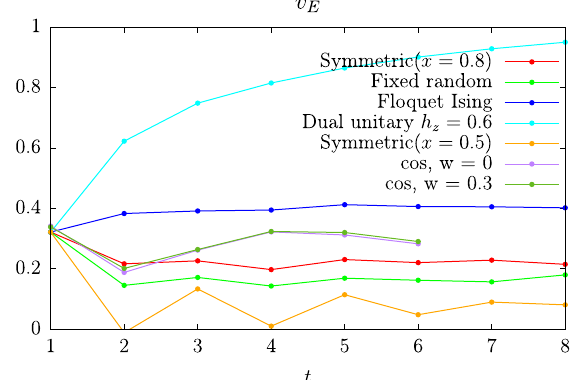
FIG. 19. The approximate entanglement velocity v computed E by truncating to times ≤ t , for t up to 8. The first four curves are for the four circuits studied in Sec. V [the first three are also the subject of Fig. 18(b) for v ]. The fifth shows the generic B symmetric gate [Eq. (72)] at a weaker coupling strength. The two curves with w ¼ 0 and w ¼ 0 . 3 are the entanglement velocities for the Floquet Hamiltonian with sinusoidal field in Eq. (107). Because of the absence of circuit structure, their starting values at t ¼ 1 are not identical to that obtained from the random average, while the others